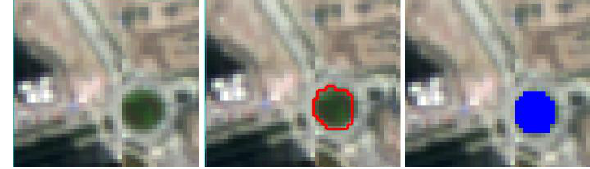
Figure 7. Evaluation. (a) Part of a remote sensing image (b) Output of automatic segment, a roundabout shapefile (c) Manually interpreted roundabout (in